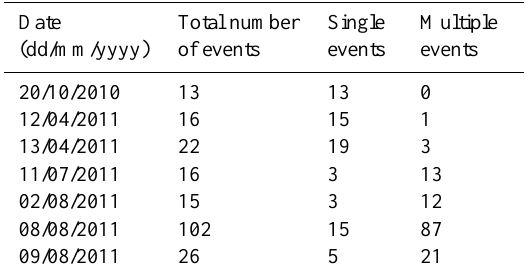
Table 4. Daily event concentrations during the period between